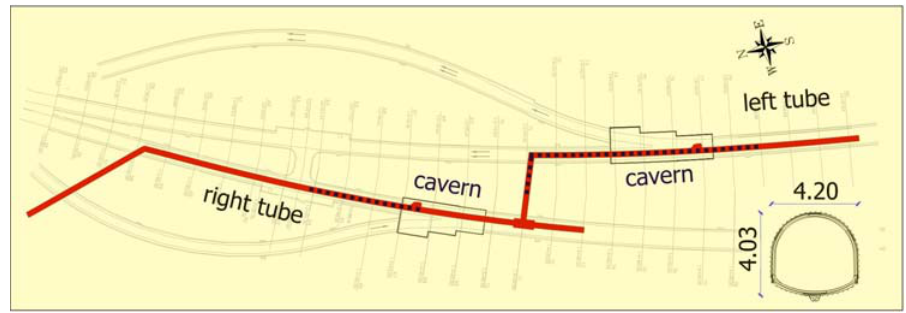
Figure 2. Ground plan and cross section of the Šentvid exploratory